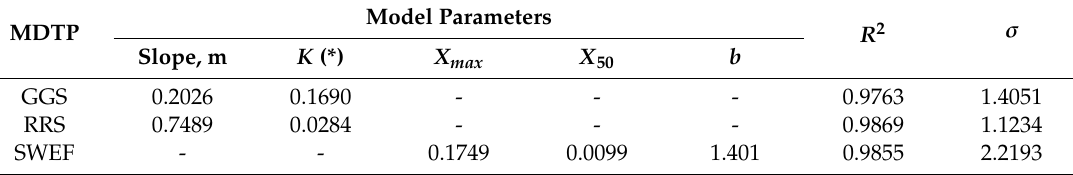
Table 4. Parameters of the distribution models for the final product of the